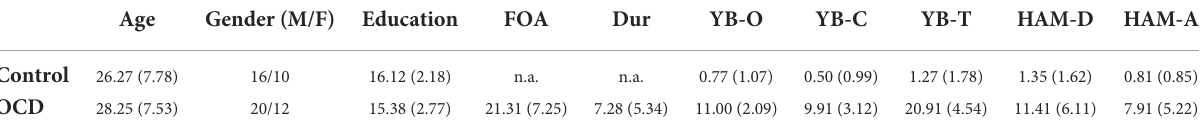
TABLE 1 Characteristics of the